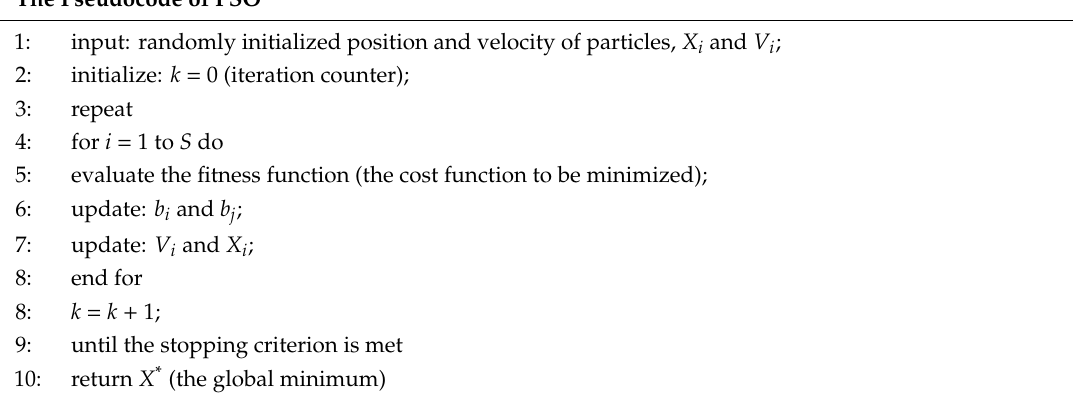
The Pseudocode of